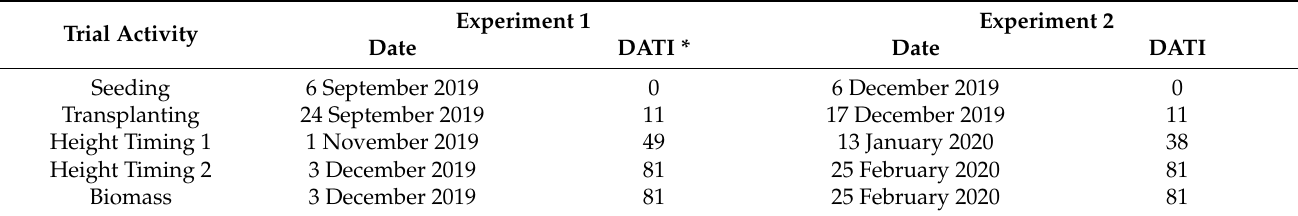
Table 1. Experimental details for greenhouse kochia and wild oat interference study conducted in Saskatoon, SK in 2019 to